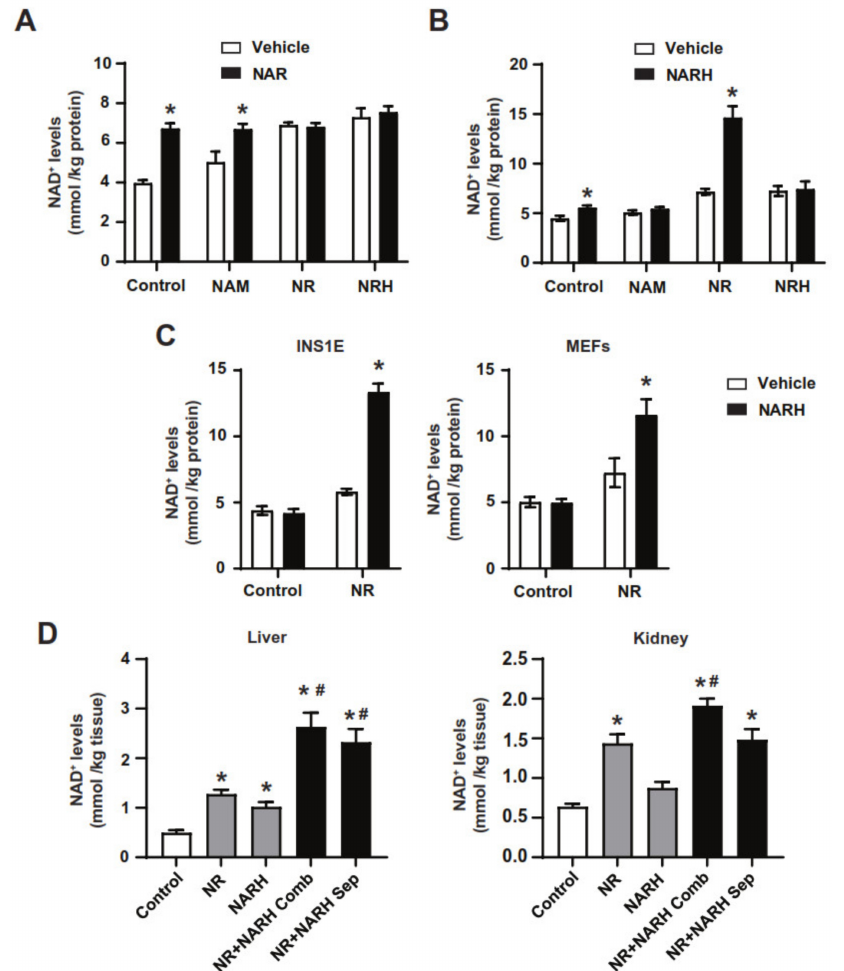
Figure 3. Interaction of NAR and NARH with other NAD + precursors. ( A ) AML12 were treated with PBS (as vehicle) or combinations of NAD + precursors as specified in the figure (NAR, 0.5 mM; NR, 0.5 mM; NAM, 5 mM; NRH, 0.01 mM). One hour later, acidic extracts were obtained to measure NAD + levels. ( B ) AML12 were treated with PBS (as vehicle) or combinations of NAD + precursors as specified in the figure (NARH, 0.5 mM; NR, 0.5 mM; NAM, 5 mM; NRH, 0.01 mM). One hour later, acidic extracts were obtained to measure NAD + levels. ( C ) INS1E and MEF cells were treated with either PBS (as vehicle), NR (0.5 mM), NARH (0.5 mM) or NR+NARH for 1 h. Then, acidic extracts ( D ) After a 2 h fast, mice were intraperitoneally injected with saline (as control vehicle) or 500 mg/kg of NR, NARH, or NR+NARH. For the NR+NARH combination, we had one group in which compounds were injected using a single mixture with both compounds and a second group where the compounds were injected separately, one in the left side of the intraperitoneum and one in the right side. One hour later, liver tissue was snap-frozen and NAD + levels were measured. All data are presented as mean +/ − SEM of n = 4 independent experiments ( A – C ) or n = 5 mice per group ( D ). * Indicates p < 0.05 vs. vehicle treated group. # Indicates p < 0.05 vs. NR and NARH